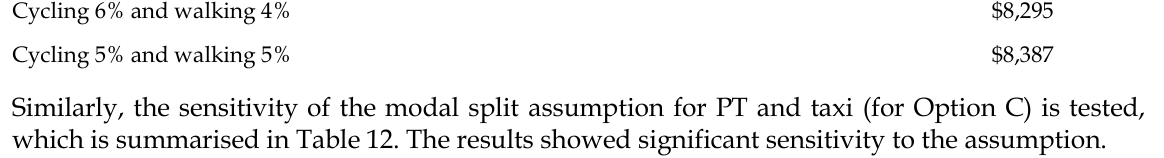
Sensitivity of modal split of PT and taxi (September 2021 dollars, per